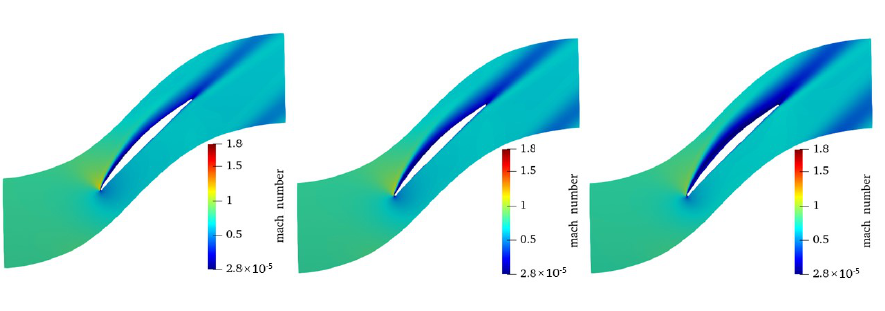
Figure 18. Mach number distribution of the three blades at the near-stall condition at 50% speed: sample_B ( left ), baseline ( middle ) and sample_W ( right ).